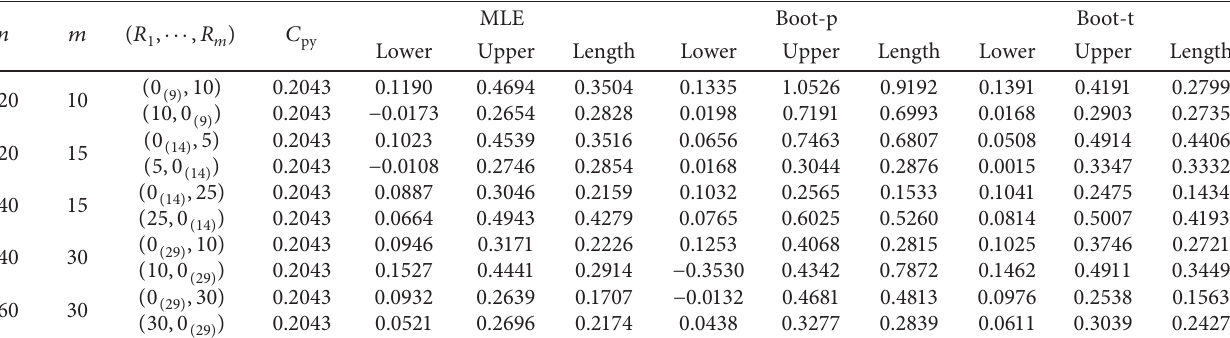
Table 7: True value of C and 95% CIs of MLE, Boot-p and Boot-t when α � 7 . 0 , θ � 4 . 0 , and c � 0 . py